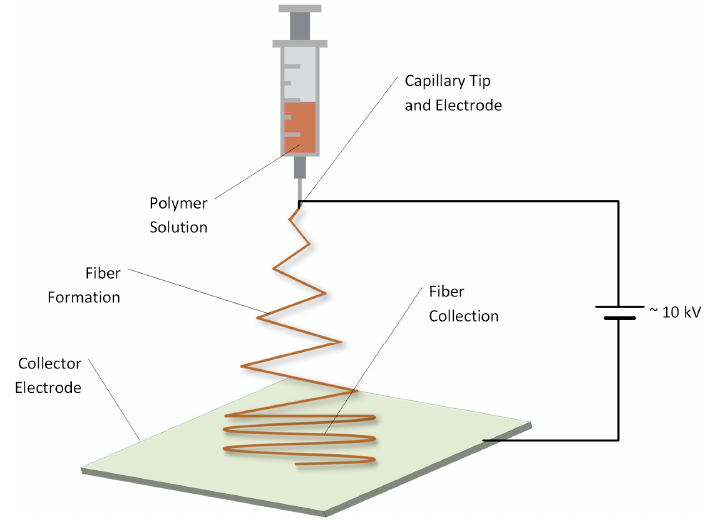
Figure 14. Schematic representation of an electrospinning setup.